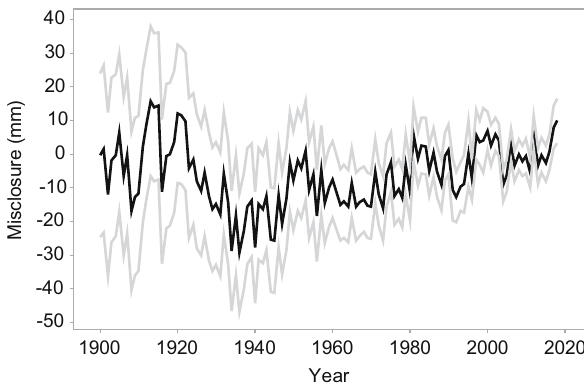
Figure 7: Yearly misclosures and their uncertaintainties ( 1 SE ) cal - culated through variance propagation using equation ( 2 ) . The weighted sum of squares of the yearly budget misclosures is WSSQ 100.3 mm. =